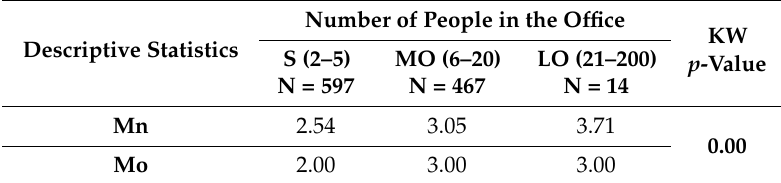
Table 5. Mean (Mn) and mode (Mo) values of the answers on noise annoyance related to the number of people in offices, and two-tailed p -value of significance of the difference between the number of people in offices, according to the KW Test. Statistically significant difference with p -value < 0.05 is reported in bold. The following abbreviations were used to indicate the type of office, on the basis of the number of people: S for “Shared office for two to five people”, MO for “Medium Open-plan office for six to 20 people”, LO for “Large Open-plan office for 21 to 200 people”. Number of People in the Office KW Descriptive Statistics